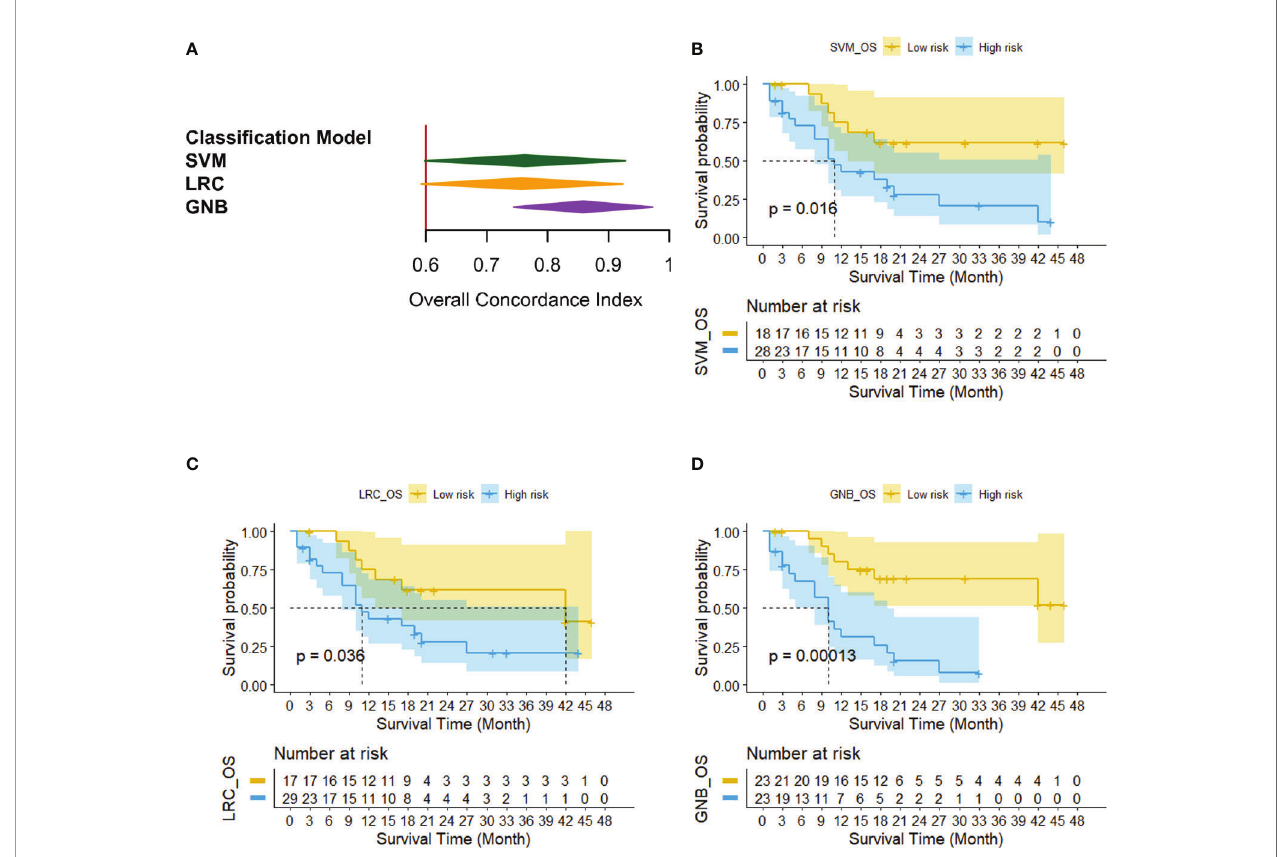
FIGURE 8 | The results of survival analysis of three OS classi fi cation models. (A) C-indexes generated by three OS prediction models, (B – D) Kaplan – Meier OS estimates from all 46 patients by using SVM, LRC and GNB classi fi er,